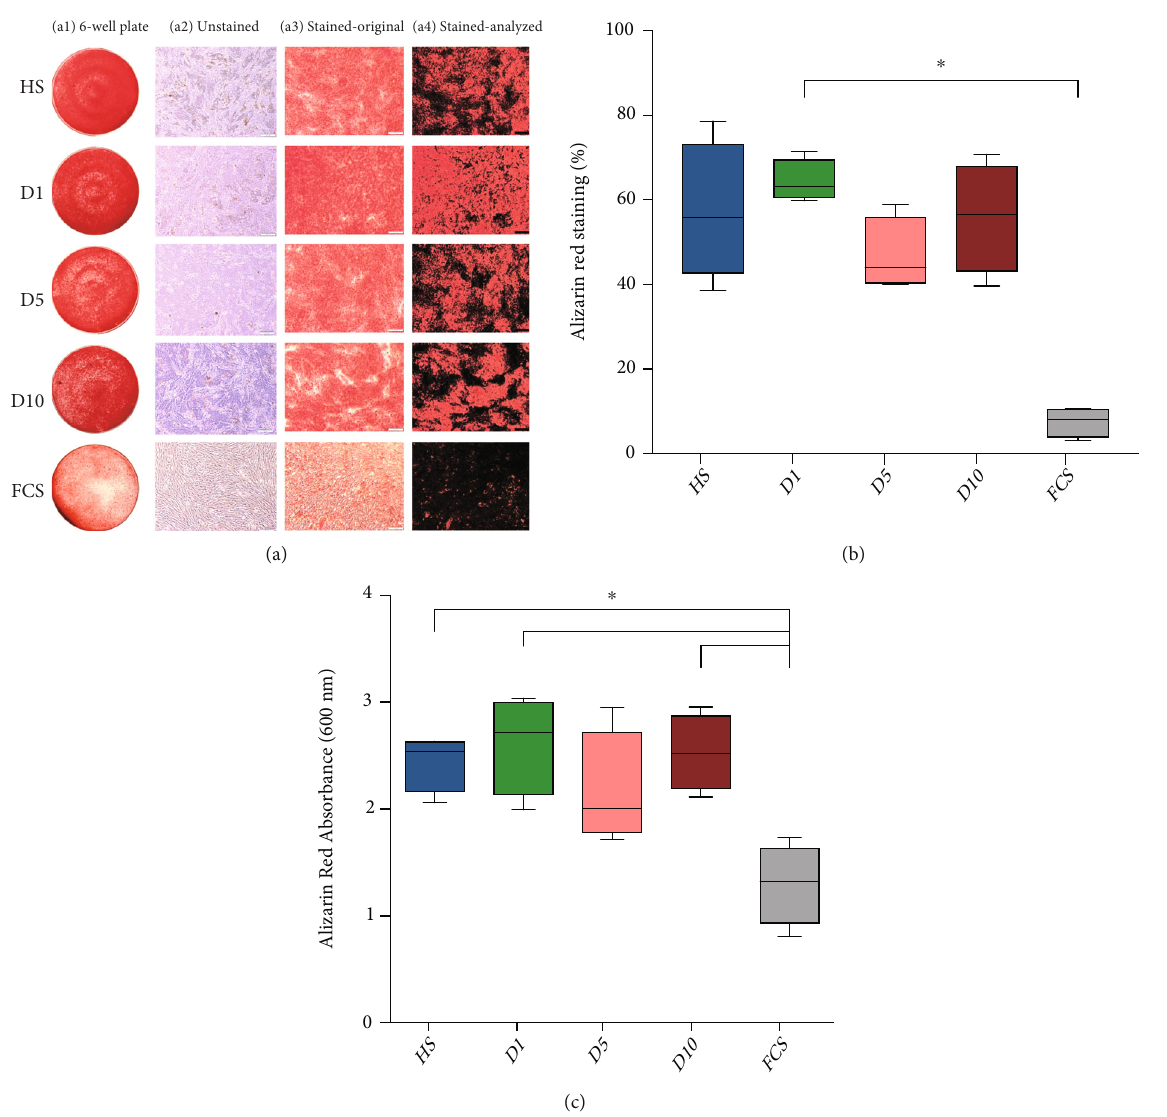
Figure 6: Osteogenic di ff erentiation potential. (a) Alizarin red staining showed calcium deposits as red staining after culturing hBMSCs in osteogenic di ff erentiation medium containing 10% serum from HS, D1, D5, D10, or FCS for 14 days. (a1) Macroscopic image of alizarin red staining. (a2) Cells prior to alizarin red staining at 40x magni fi cation. (a3) Images showing the hBMSCs at a 40x magni fi cation after staining with alizarin red. (a4) Analysis of alizarin red staining of calcium deposits using a tool based on OpenCV library (version 4.1.0). Areas without staining were color isolated as black areas. The pixel ratio of the area of interest (nonblack area) in comparison to the black area was obtained. In the groups containing human serum (HS, D1, D5, and D10), a larger area of the 6-well was positive for alizarin red staining than in the FCS group ( n = 4 ). (b) Quantitative analysis of the amount of alizarin red staining quanti fi ed using a software tool to compare the relative areas positive for staining. D1 showed signi fi cantly more area of alizarin red staining when compared to the FCS group. ∗ p ≤ 0 : 05 ( n = 4 ). (c) Analysis of alizarin red staining indicative of osteogenic di ff erentiation with higher concentrations of calcium deposition after 14 days of culture. HS, D1, and D10 showed signi fi cantly higher absorbance as compared to the FCS group. ∗ p ≤ 0 : 05 ( n = 4